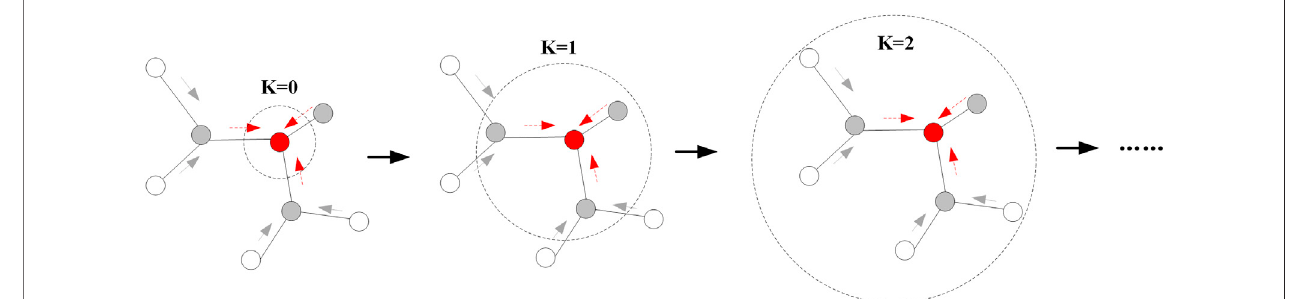
FIGURE 3 | Schematic diagram of node feature update based on graph convolutional neural network.